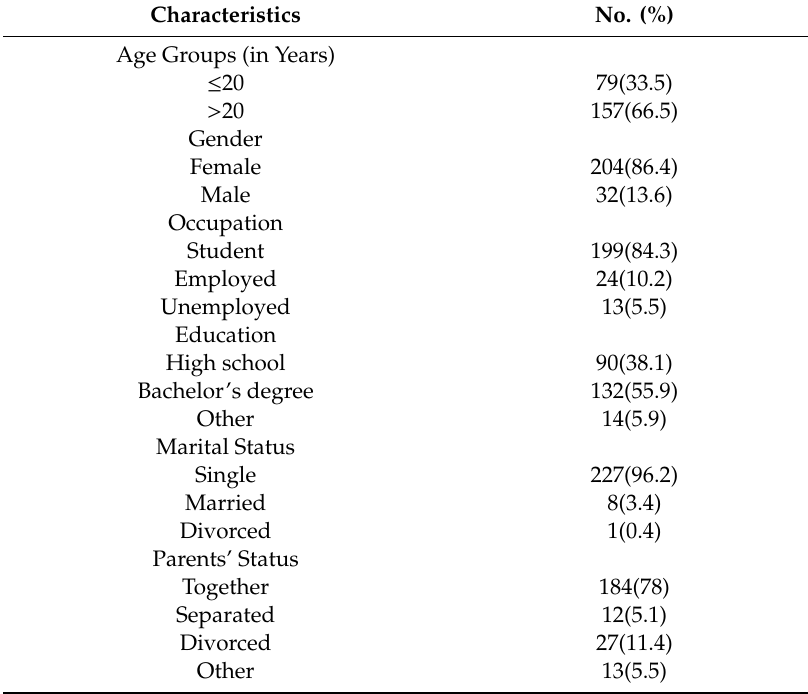
Table 1. Distribution of characteristics of study subjects ( n = 236).